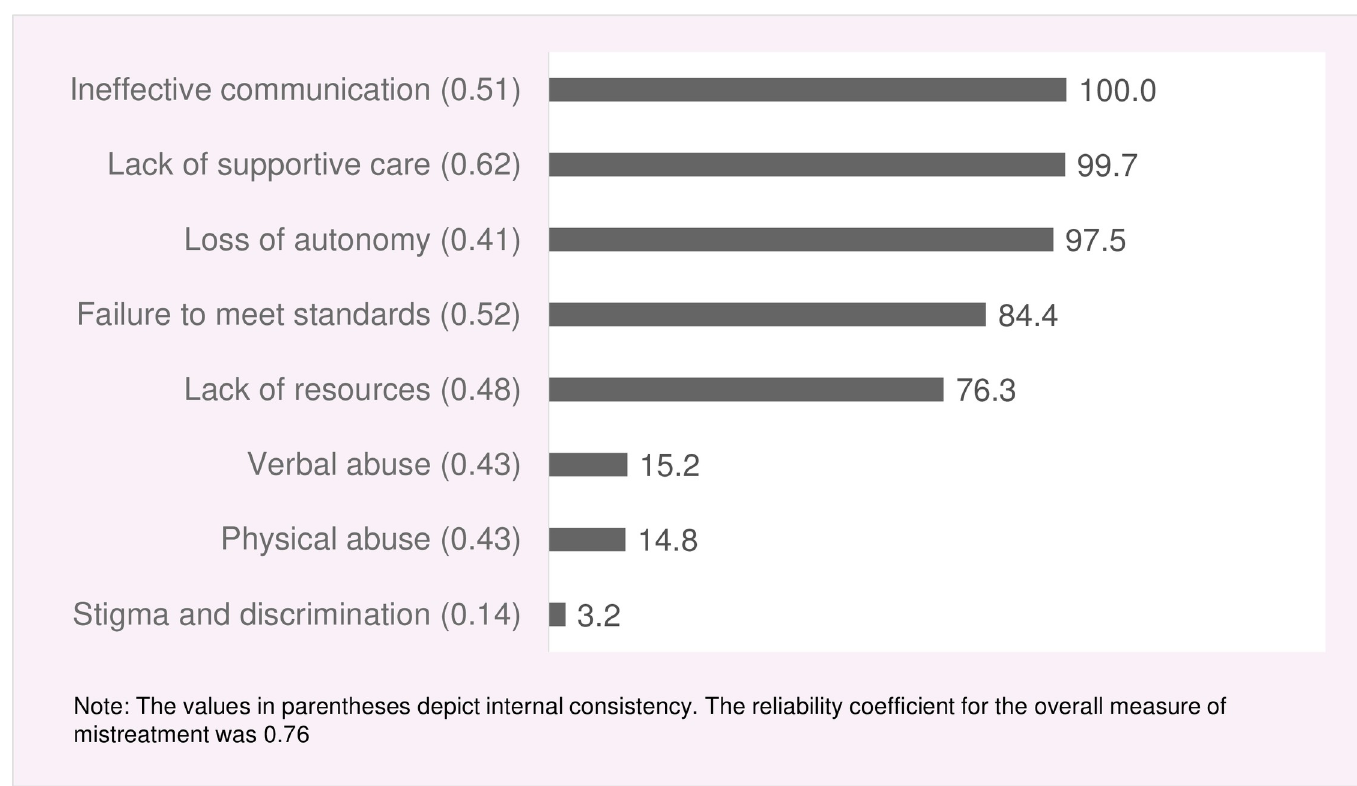
Fig 3. Prevalence of mistreatment during childbirth in facility-based settings, according to type of mistreatment.